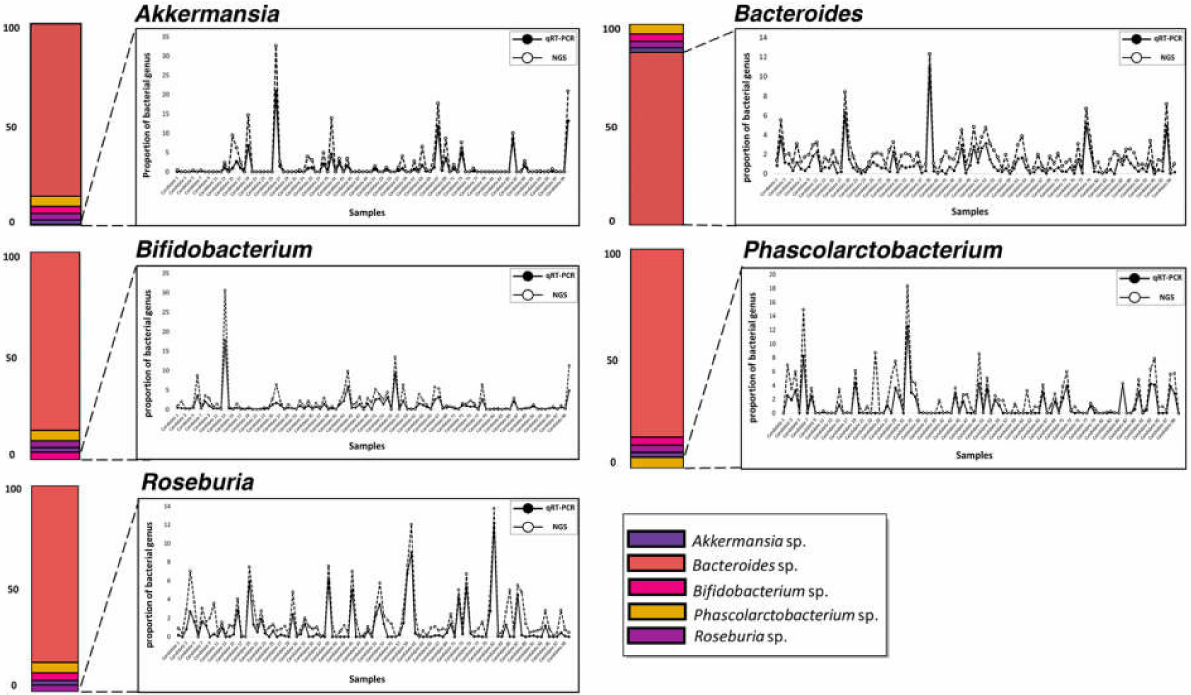
Figure 3. Parallel comparison of the five bacterial genera proportions measured from two different quantification methods. Multiple overlaid connected line graphs show the quantitative identity of each bacterial genus measured by both methods. The graph’s x -axis indicates the 100 samples (denote as ‘candidate’), and the y -axis indicates the relative proportion value for each particular bacterial genus. The bar plot shown on the left side represents an average abundance of the five bacterial genera calculated from 16S metagenomic profiling